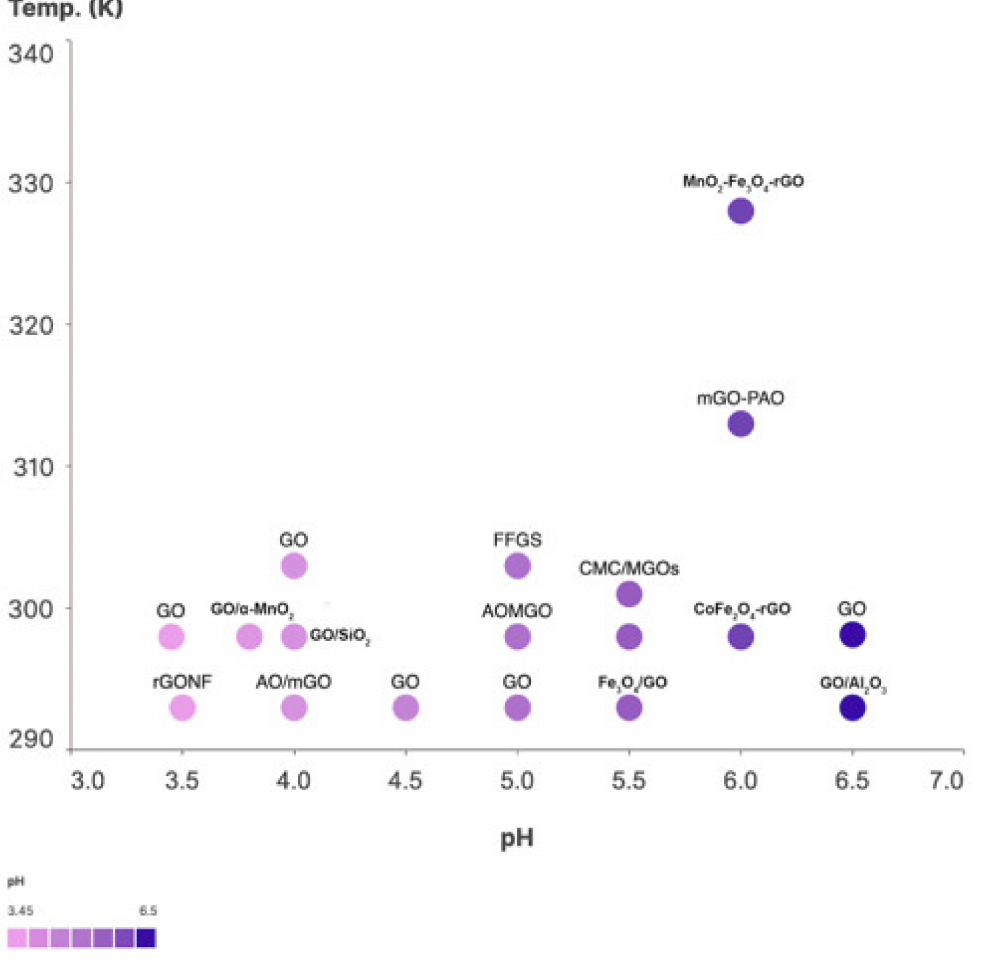
Figure 4. Temperature vs. pH of GO-M hybrid adsorbents of uranium adsorbates. Data listed in Table